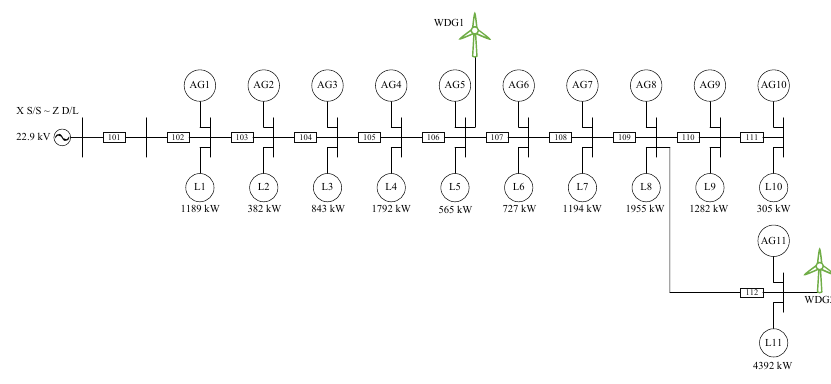
Figure 7. Korea Electric Power Corporation feeder